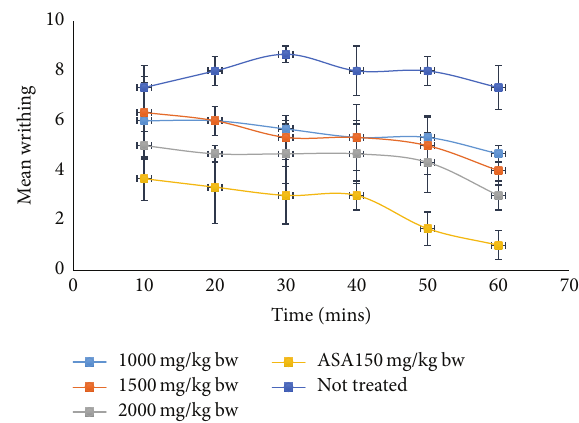
Figure 1: Analgesic effect of crude ethanol extract of Piper guineense leaf in